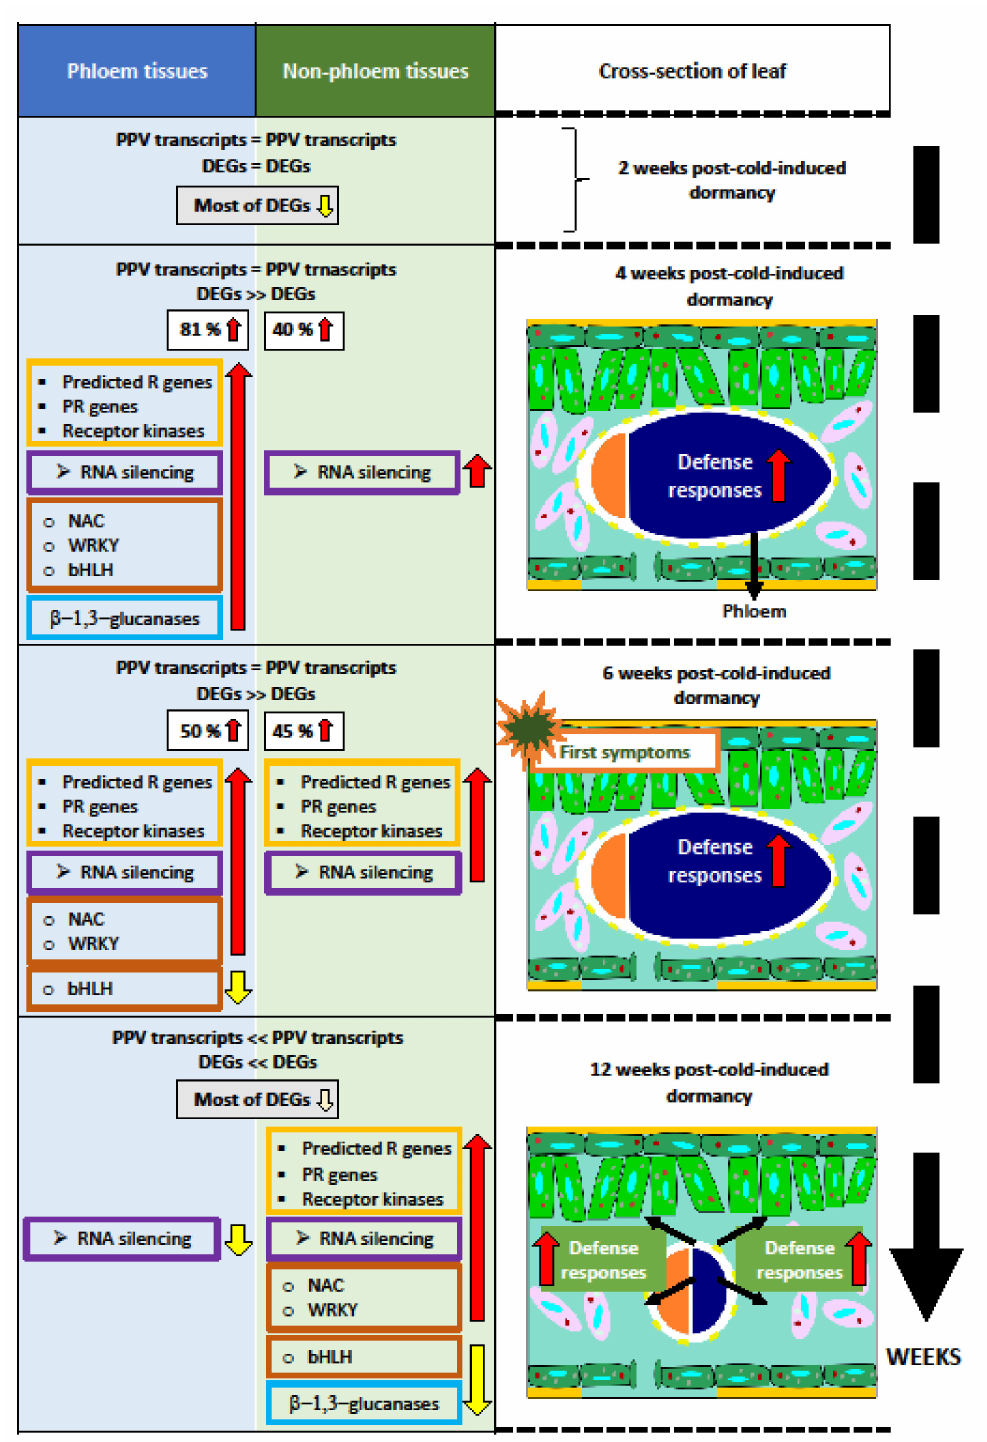
Figure 3. Temporal and spatial dynamics of leaf tissues responses at the translation level to virus infection. The figure is separated into three parts: in blue (left), the modifications induced in the phloem tissues; in green (middle), the modifications induced in the non-phloem tissues; and on the right, a cross-section of a leaf illustrating the main modifications. Red arrows indicate overexpression, and yellow arrows indicate under-expression. Differentially expressed genes (DEGs) have been grouped by color for a better overview. The major responses to PPV infection are expressed early in phloem tissues and are manifest later in the non-phloem tissues. Results correspond to Collum et al. [25]. bHLH: basic-helix-loop-helix and NAC transcription factor: NAM, AFAT, and